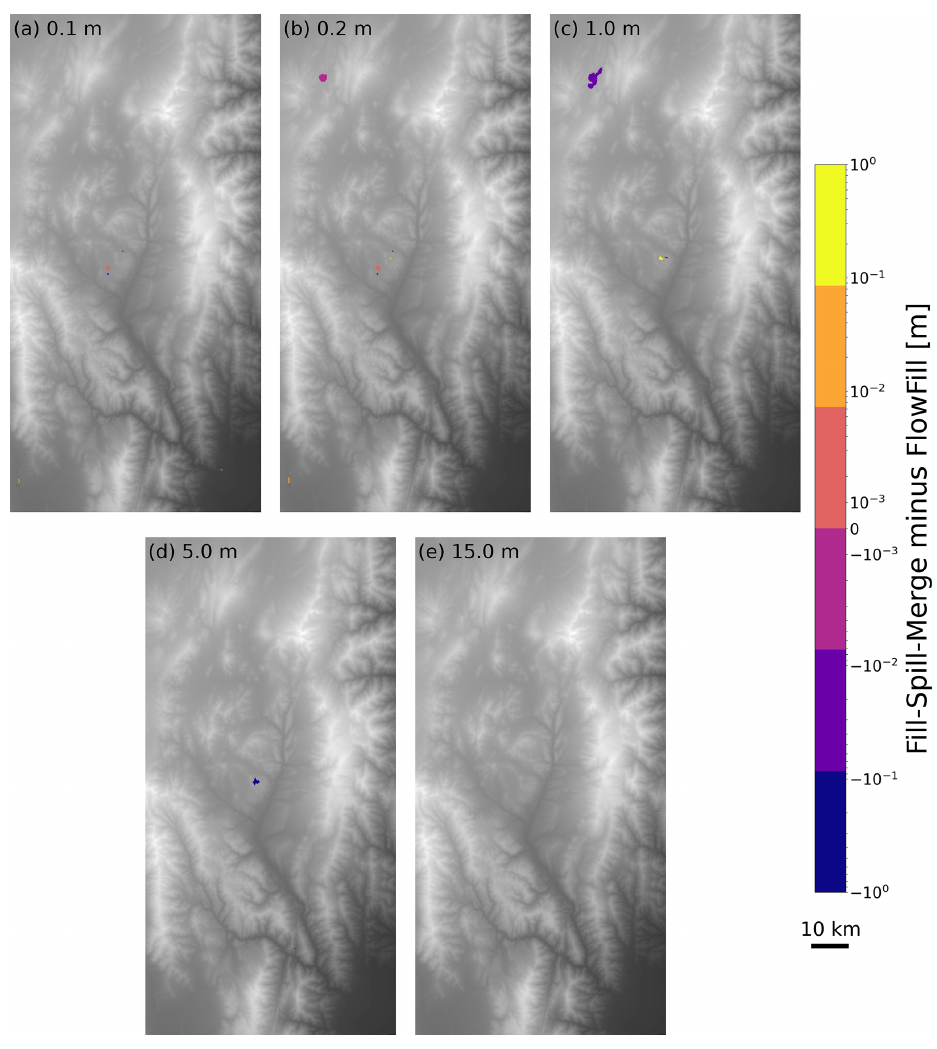
Figure 8. The difference between results of Fill–Spill–Merge and FlowFill at the Río Toro site. The values for panels (a) to (e) indicate the depth of uniform runoff applied across the landscape for both algorithms. For example, in (a) , each cell across the domain starts with 0.1m of surface water. Orange to yellow indicates locations where Fill–Spill–Merge had more water, and purple to blue indicates locations where FlowFill had more water. Differences of less than 3mm have been masked out. In panel (e) , 15m of water was enough to fill all depressions with both algorithms, so there are no differences between the two. The most significant difference is seen in panel (c) , where FlowFill retained additional water in a large depression. This is likely due to transient damming of its narrow inlet in FlowFill’s cell-by-cell method of moving water, which may have prevented the full volume of water from leaving the depression. This DEM was generated with data acquired from the TanDEM-X mission (Krieger et al., 2013; Rizzoli et al.,